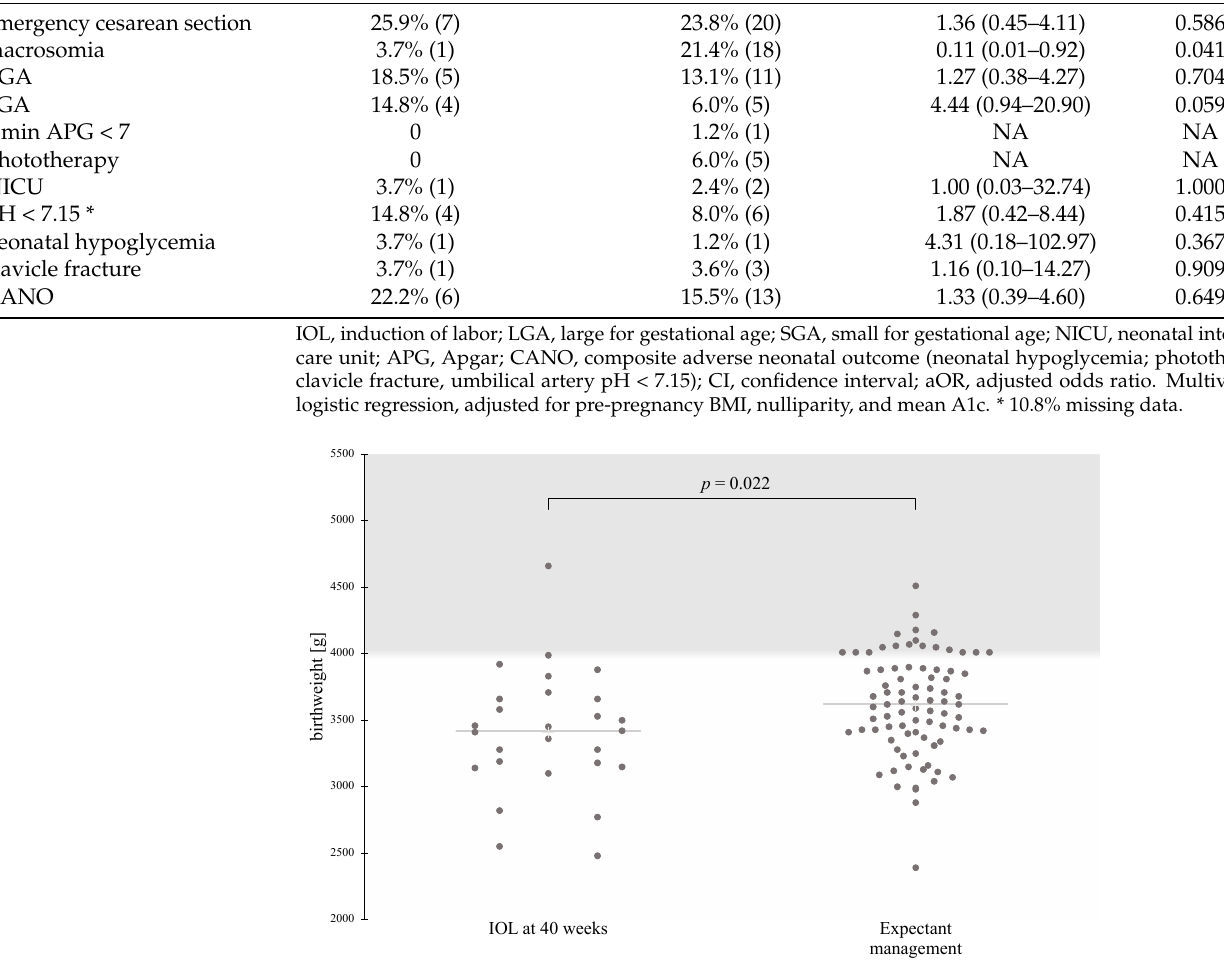
Figure 1. Scatterplot showing the mean birthweight and number of macrosomic newborns in the IOL at 40 weeks and Expectant management groups. Birthweight follows a normal distribution pattern, and data are compared using the t -test for the two independent samples. IOL, induction of labor.